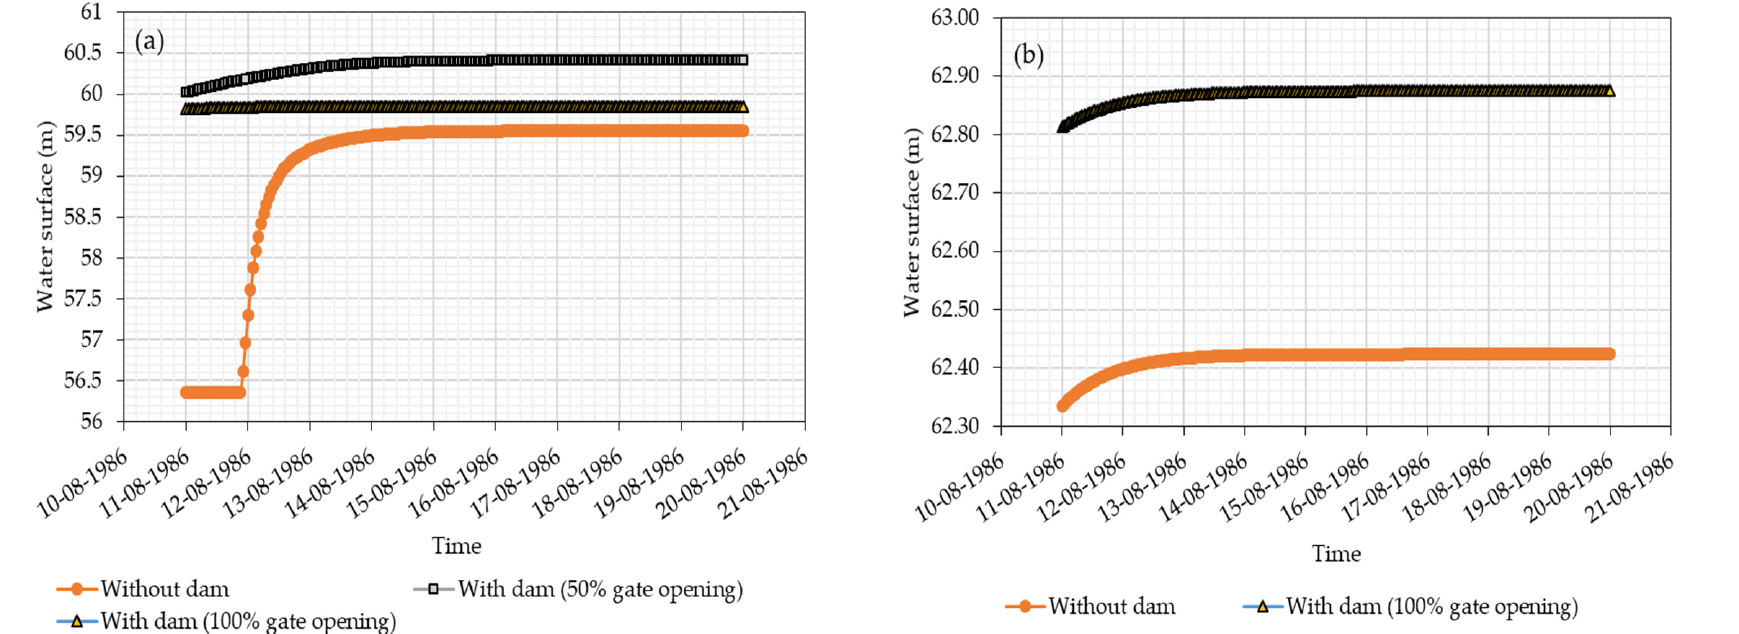
Figure 11. 2D unsteady flow simulated for ( a ) 0.10 million m 3 /s with and without dam ( b ) 0.14 million m 3 /s discharge with and without a dam.